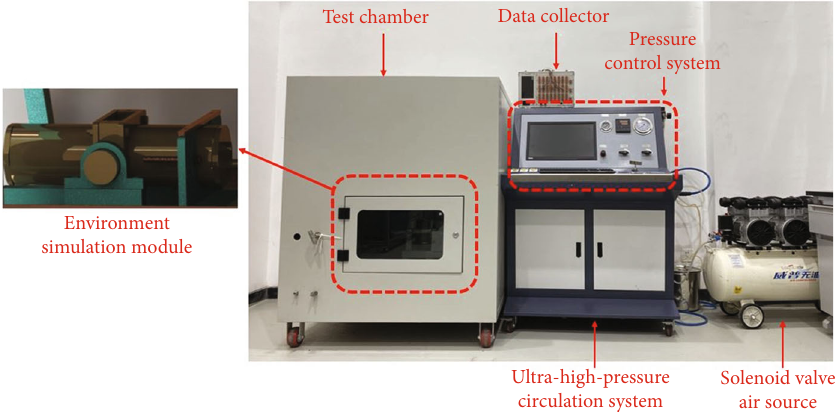
Figure 9: Physical diagram of the experimental